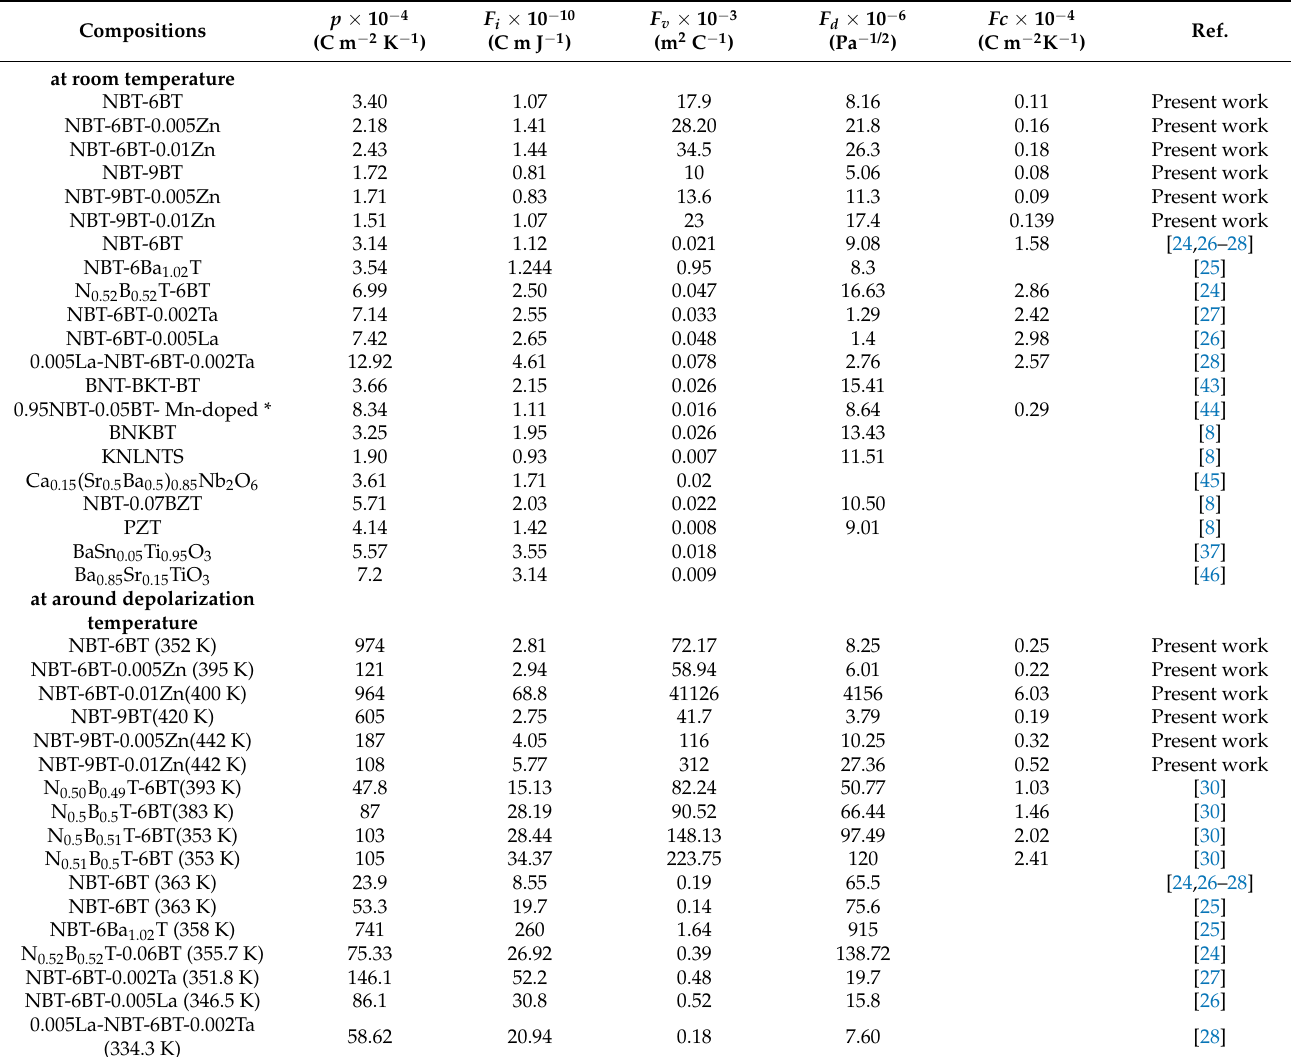
Table 1. Comparison of the pyroelectric coefficient and FOMs (after the tenth cycle of heating) at room temperature and depolarization temperature (T d ) for some important bulk